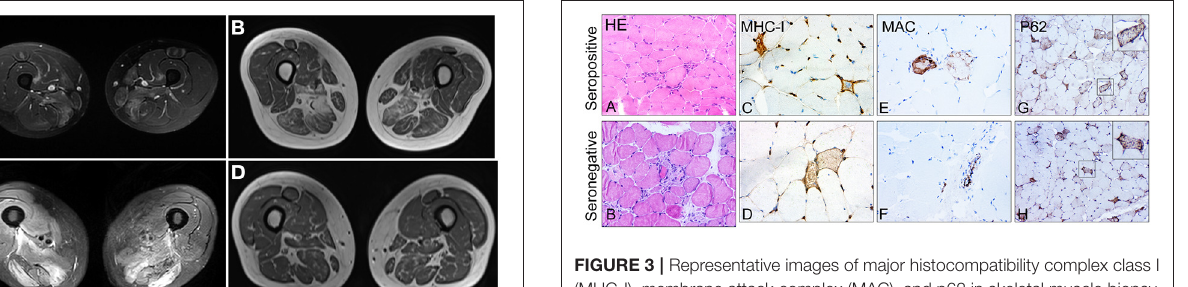
FIGURE 3 | Representative images of major histocompatibility complex class I (MHC-I), membrane attack complex (MAC), and p62 in skeletal muscle biopsy of patients with seropositive and seronegative immune-mediated necrotizing myopathy (IMNM). (A,B) Representative images of hematoxylin–eosin (HE)-stained sections showing numerous necrotic and regenerating fibers. Original magnification: × 200. (C,D) Representative images of upregulation of MHC-I. Original magnification: × 400. (E,F) Representative images of sarcoplasmic MAC deposition on fibers in biopsied samples of patients with seropositive IMNM and vascular immunostaining pattern for MAC in patients with seronegative IMNM. Original magnification: × 400. (G,H) Representative images of a diffusely fine and homogeneous staining pattern with variable intensity of P62 in muscle biopsies. Original magnification: ×